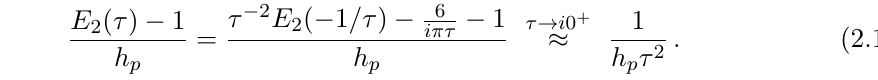
Figure 1 . Plotting arg[ H ( q )] — [left] for the 1-point torus block till O (1 /h 6 disk with c = 1 , h = 4 , h p = 6 ; and [right] for the 4-point block on the sphere till O (1 /h 4 parameters c = 3 , h = 0 . 8 , h p = 8